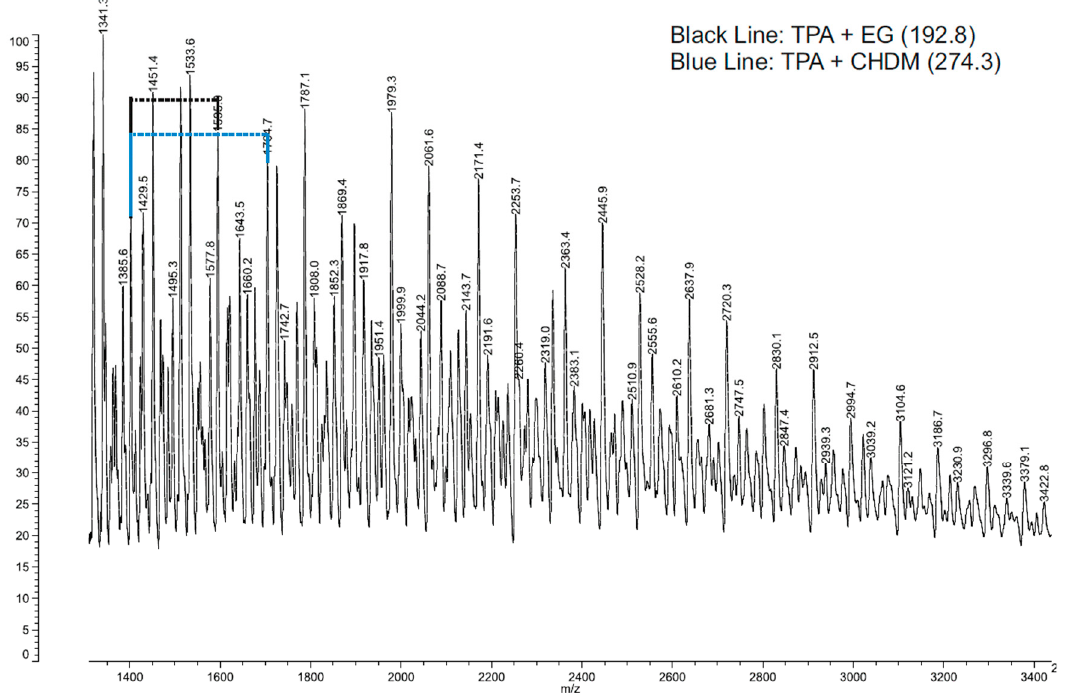
Figure 1. The Matrix-assisted laser desorption/ionization time-of-flight mass spectrometry (MALDI-TOF MS) spectrum of Polyethylene terephthalate glycol modified (PETG). Its characteristic repeated units are highlighted: 192.8 g/mol for the Terephthalic acid + Ethylene Glycol (TPA + EG) unit and 274.3 g/mol for Terephthalic acid + Cyclohexanedimethanol (TPA + CHDM). Table 2. Chemical constituents for PETG. Compound Molecular Formula Molecular Weight (g/mol)